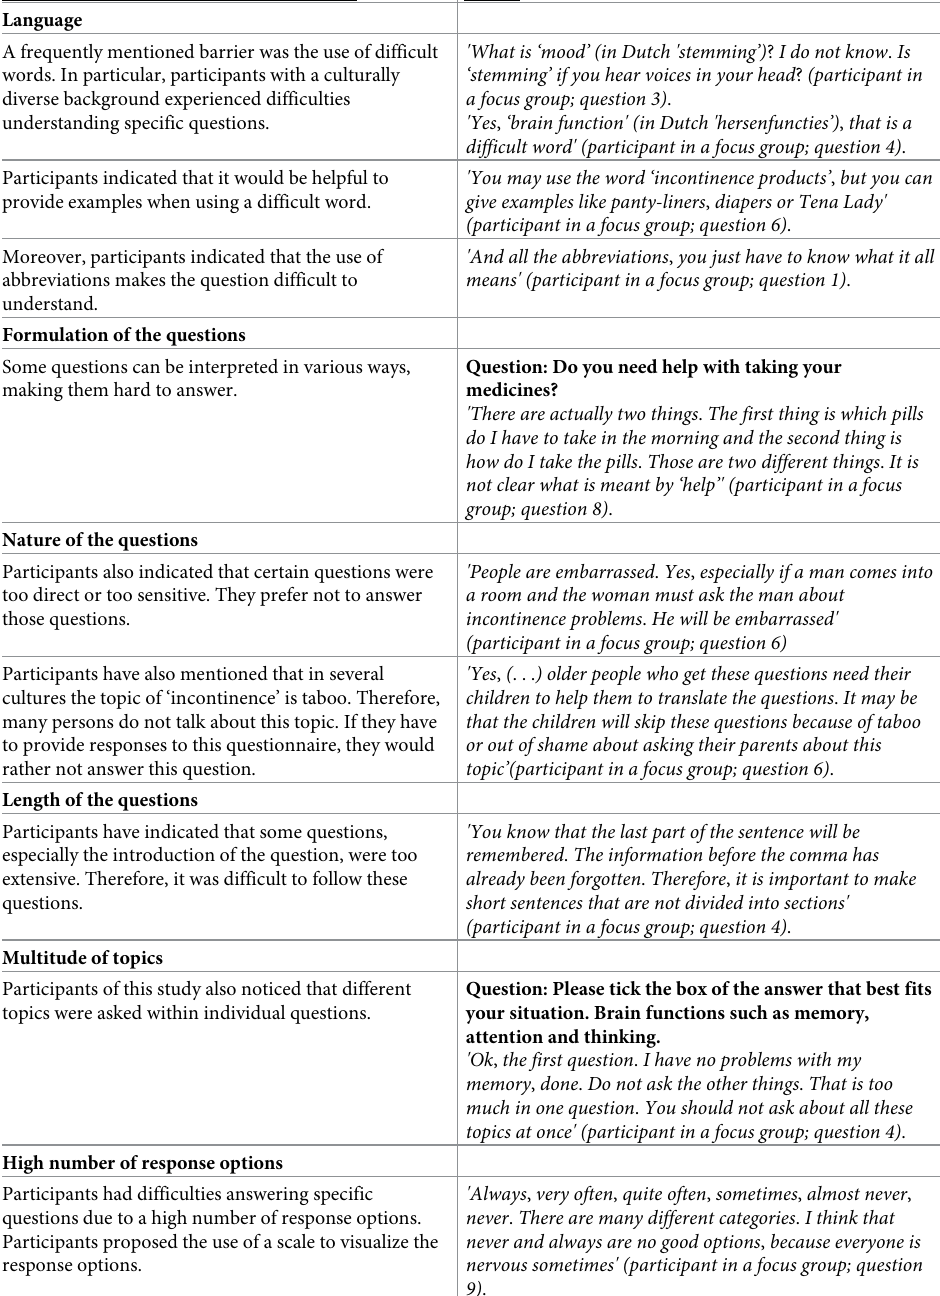
Table 2. Comprehensibility of the questions (Qualitative data from the focus groups, Round 2). Barriers to the understanding of questions